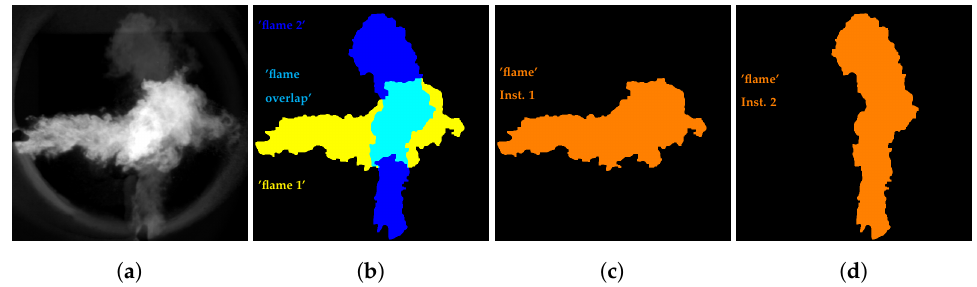
Figure 2. Difference in the class partition between semantic and instance segmentation. ( a ) Flame image example, ( b ) corresponding semantic (“instance-like”) ground truth, and ( c , d ) one partition per flame for instance segmentation. The colors encode class information. In the semantic example each flame segment is a different class (“flame 1”, “flame 2”, “flame overlap”), whereas for true instance segmentation each instance has its own partition of the same general class